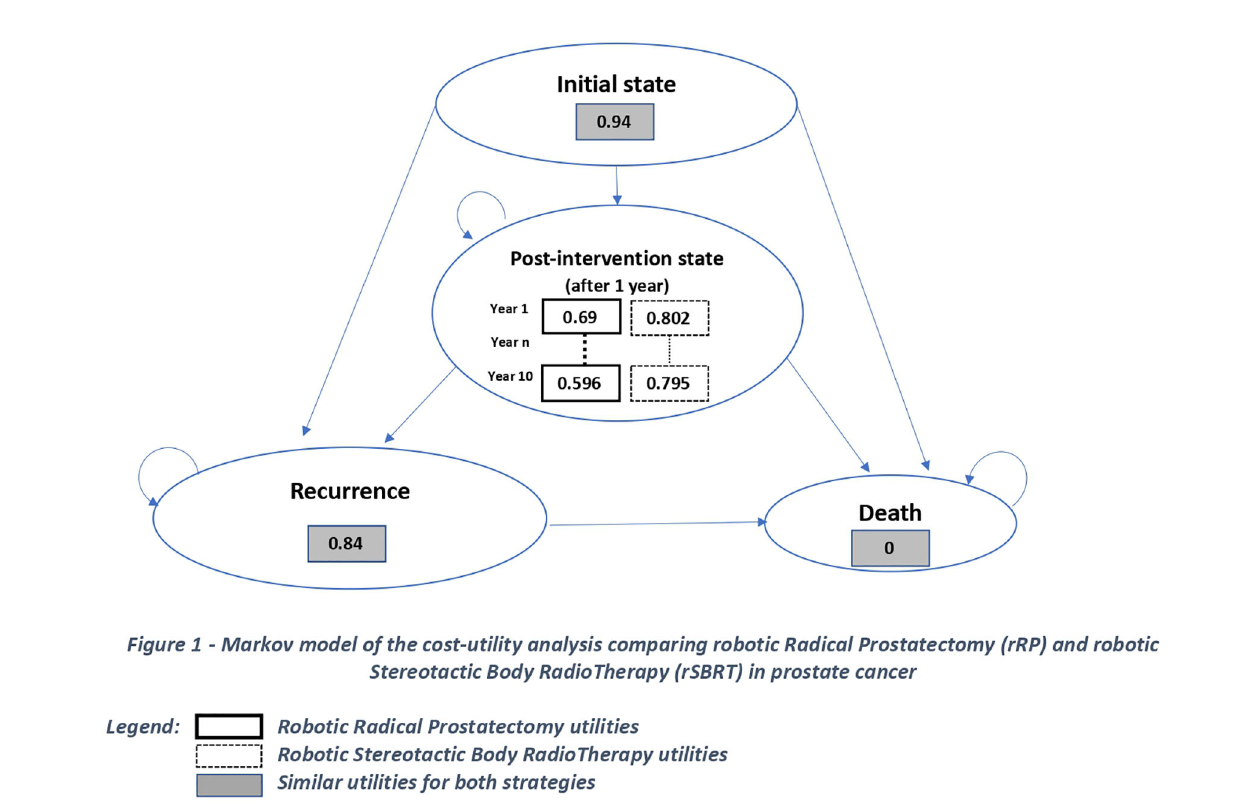
FIGURE 1 | Markov model of the cost-utility analysis comparing rRP and rSBRT in prostate